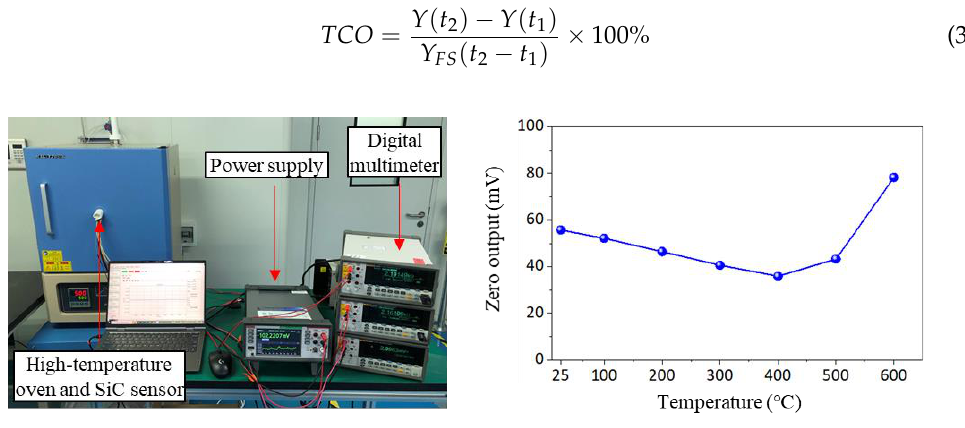
Figure 12. Experimental setup and zero offset drift curve. Table 4. Thermal zero offset drift coefficient (TCO) of the